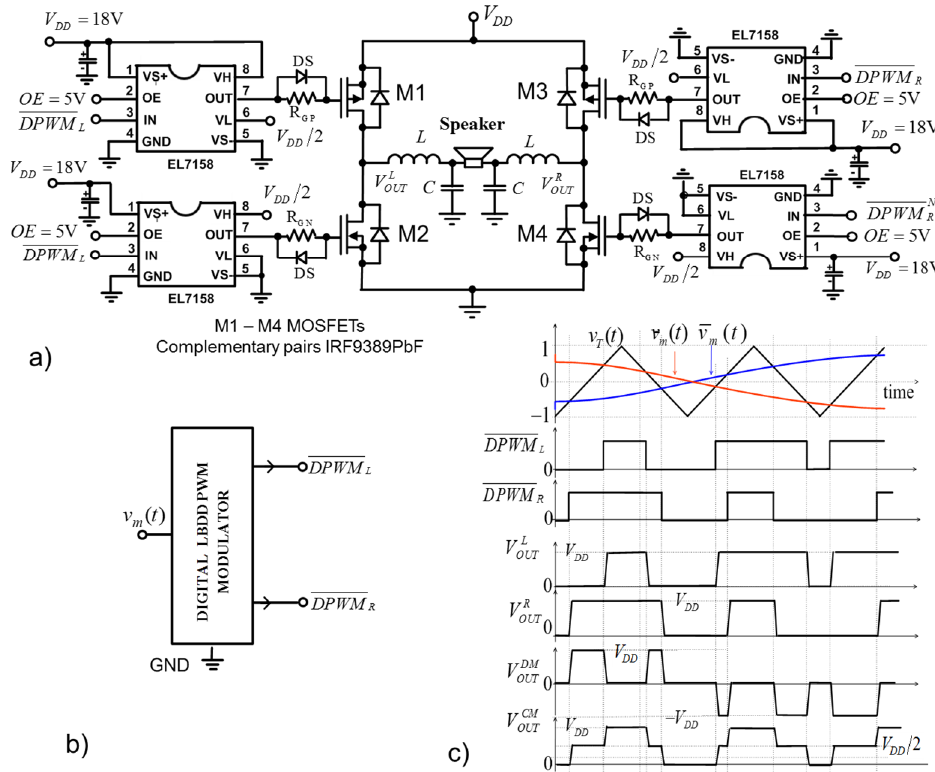
Figure 3. Digital Class-BD amplifier using LBDD PWM modulator: ( a ) circuit diagram; ( b ) block diagram of digital LBDD PWM modulator; ( c ) control signals and DM and CM output voltages.